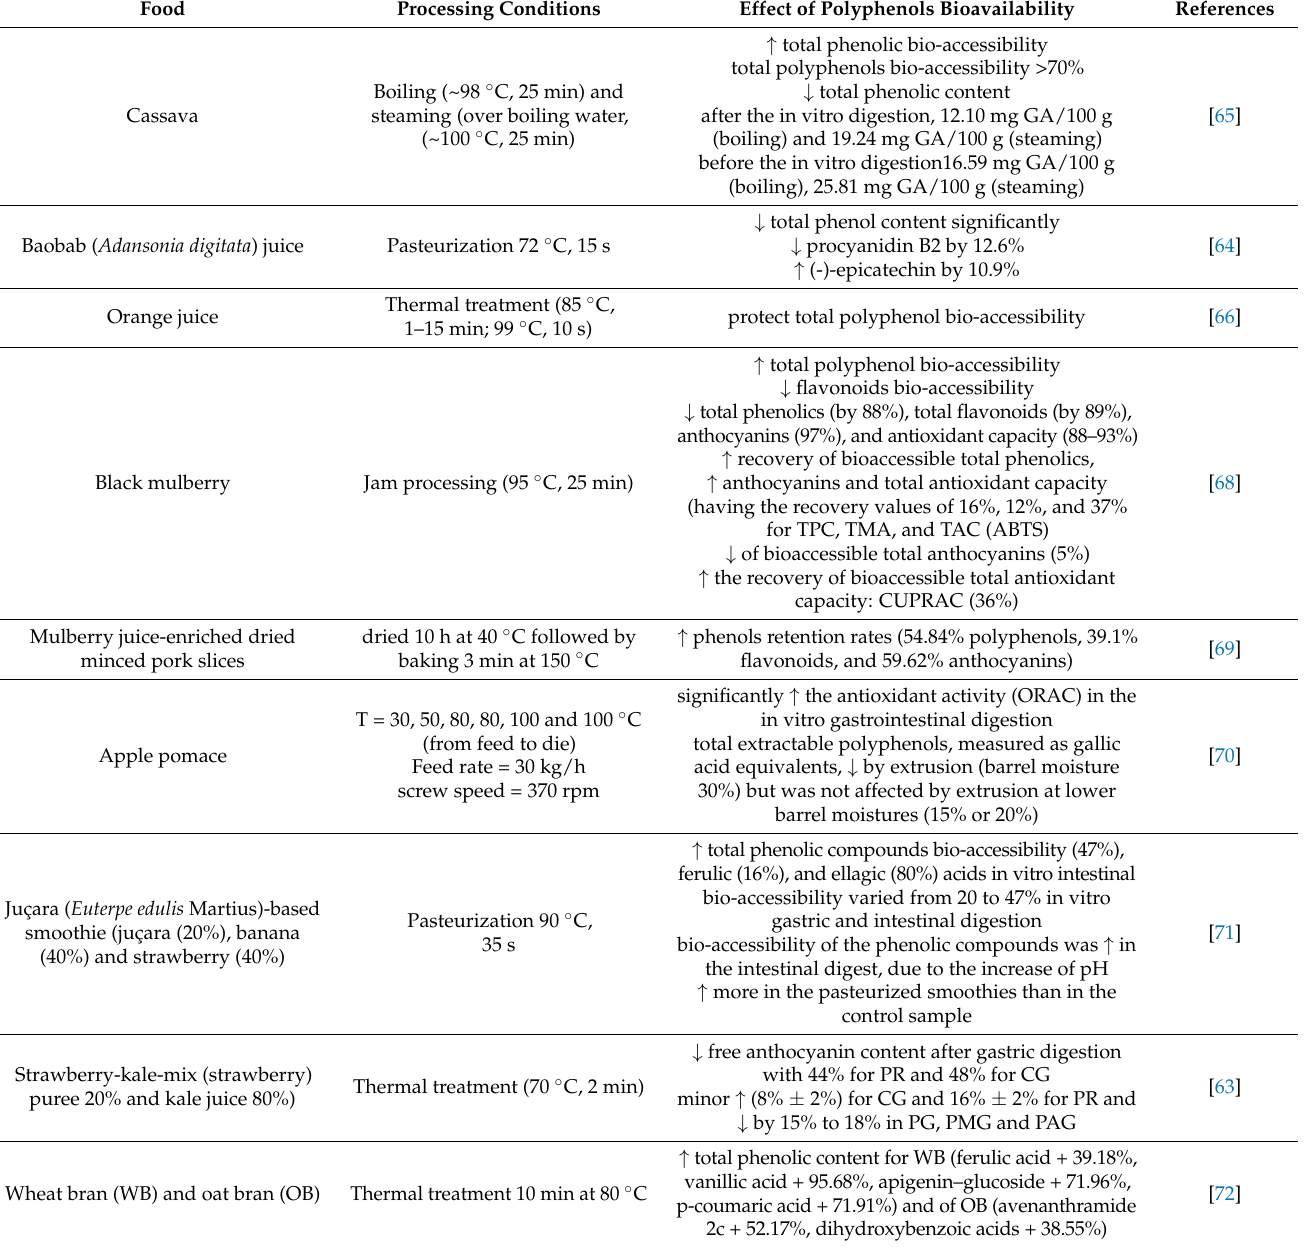
Table 1. Effect of thermal treatment on polyphenol